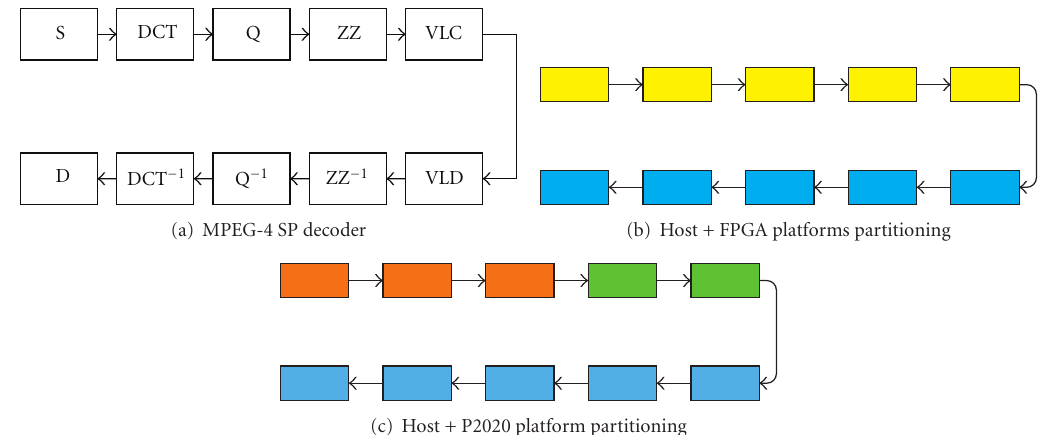
Figure 13: Description of the JPEG codec and the partitioning for the